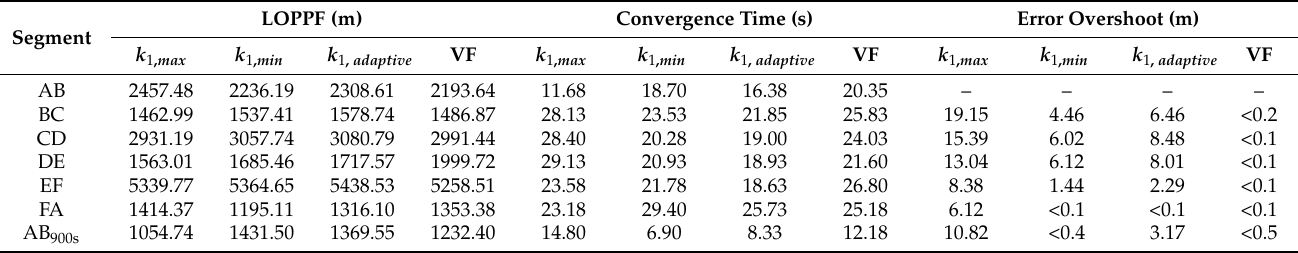
Table 3. The performance comparison of the polygon path following using the four